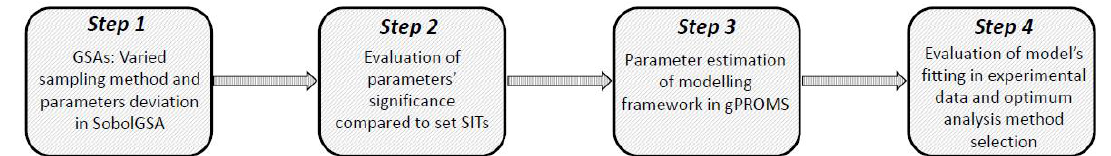
Figure 1. Strategic framework for the evaluation of different sensitivity analysis. The framework combines sensitivity analysis in the SobolGSA software and parameter estimation in gPROMS.